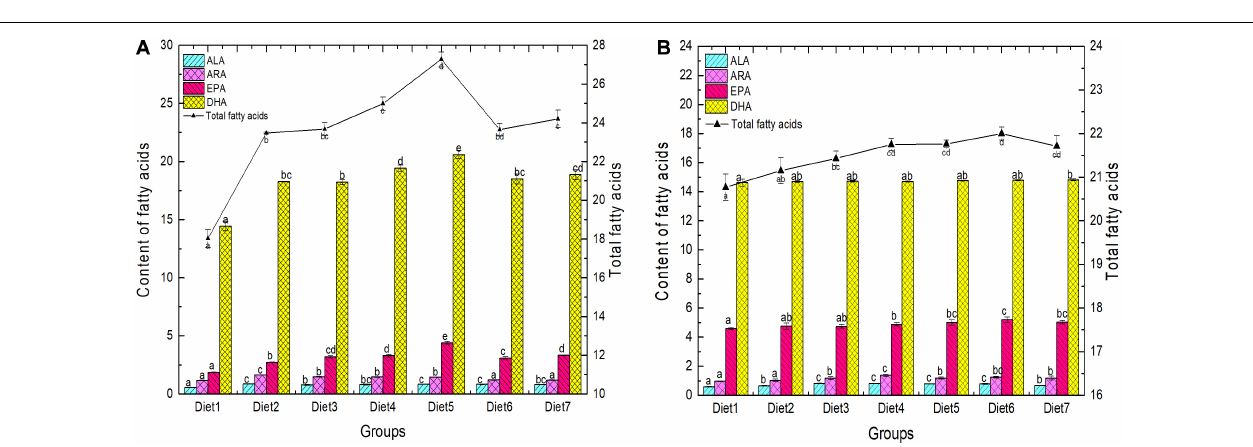
FIGURE 2 | Fatty acid composition in liver (A) and muscle (B) of T. ovatus sp. Diet1 ∼ 7 for Fish feed with different n -3 PUFAs contents in 7 groups. The amount of Aurantiochytrium sp. powder in feed is 0.00%, 1.00%, 3.00%, 5.00%, 7.00%, 9.00%, and 11.00%,